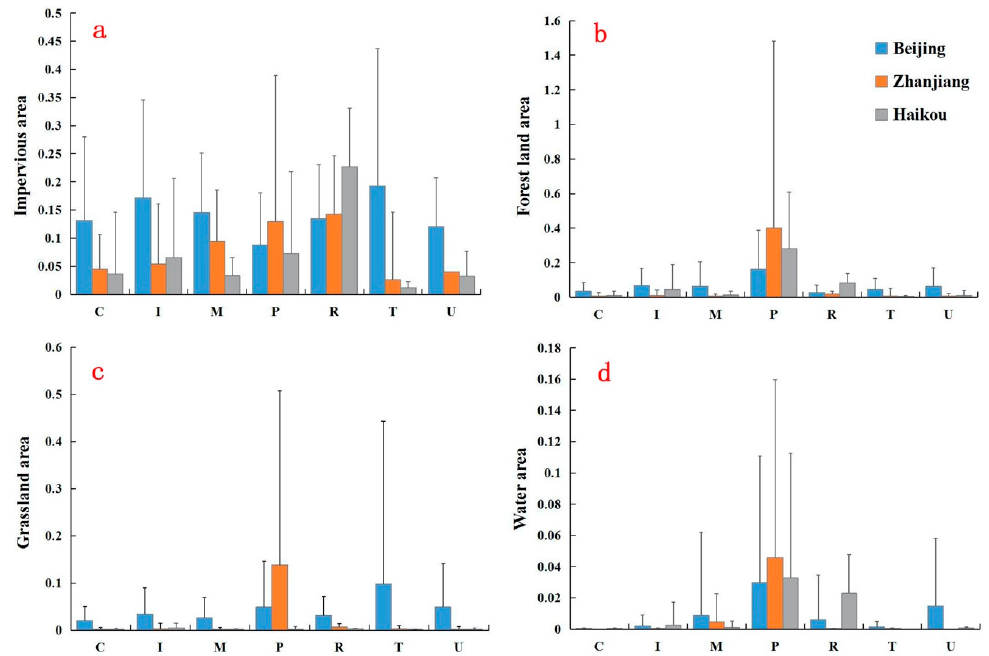
Figure 2. Areas of primary urban functional units in Beijing, Zhanjiang, and Haikou for impervious area (km 2 ) ( a ), forest land area (km 2 ) ( b ), grassland area (km 2 ) ( c ), and water area (km 2 ) ( d ). Table 1. A summary of the predictor variables used in the analysis as well as the units and transformations associated with